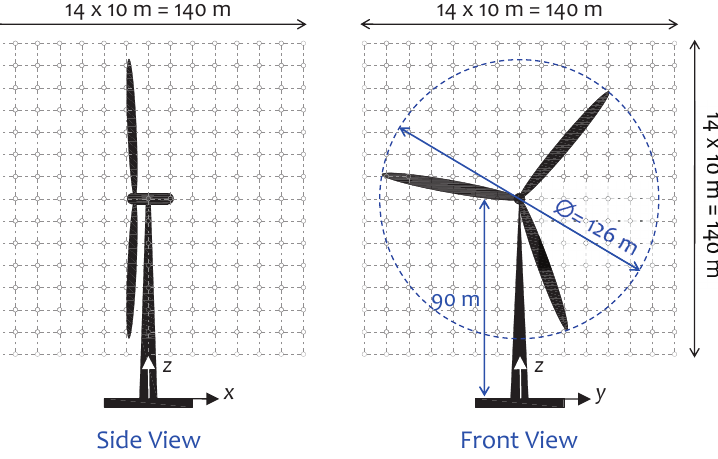
Figure 4. Mesh used for generating wind velocity field in turbine loads